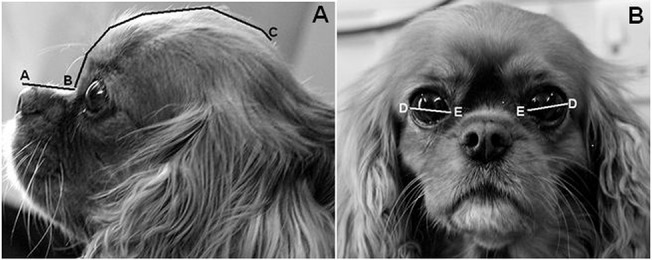
Quantifying muzzle length (A-B), cranial length (B-C) and palpebral fissure width (D-E).
A, left: Muzzle length is defined as the distance (mm) from the dorsal tip of the nasal planum to the stop. Cranial length is defined as the distance (mm) from the stop to the occipital protruberance. B, right: Palpebral fissure width is defined as the straight-line distance (mm) between the medial and lateral canthus. As an example, this Cavalier King Charles Spaniel has a craniofacial ratio of 0.27 (muzzle length 28mm / cranial length 102mm), and a relative palpebral fissure width value of 33.3% ((palpebral fissure width 34mm / cranial length 102mm) *100)